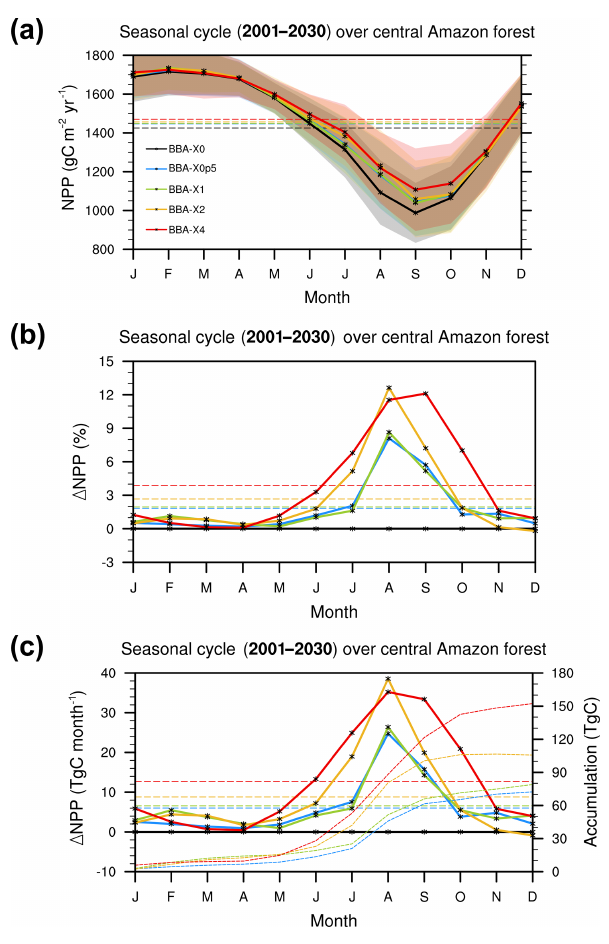
Figure 6. Mean seasonal cycle of NPP ( a ), relative changes ( b ) and absolute changes ( c ) for the five BBA emission scenarios (see text, Sect. 2.2) averaged over the Amazon Basin. Differences are calcu- lated with regard to experiment BBAx0. The short-dash curves in panel (c) correspond to the accumulated anomalies (right y axis).